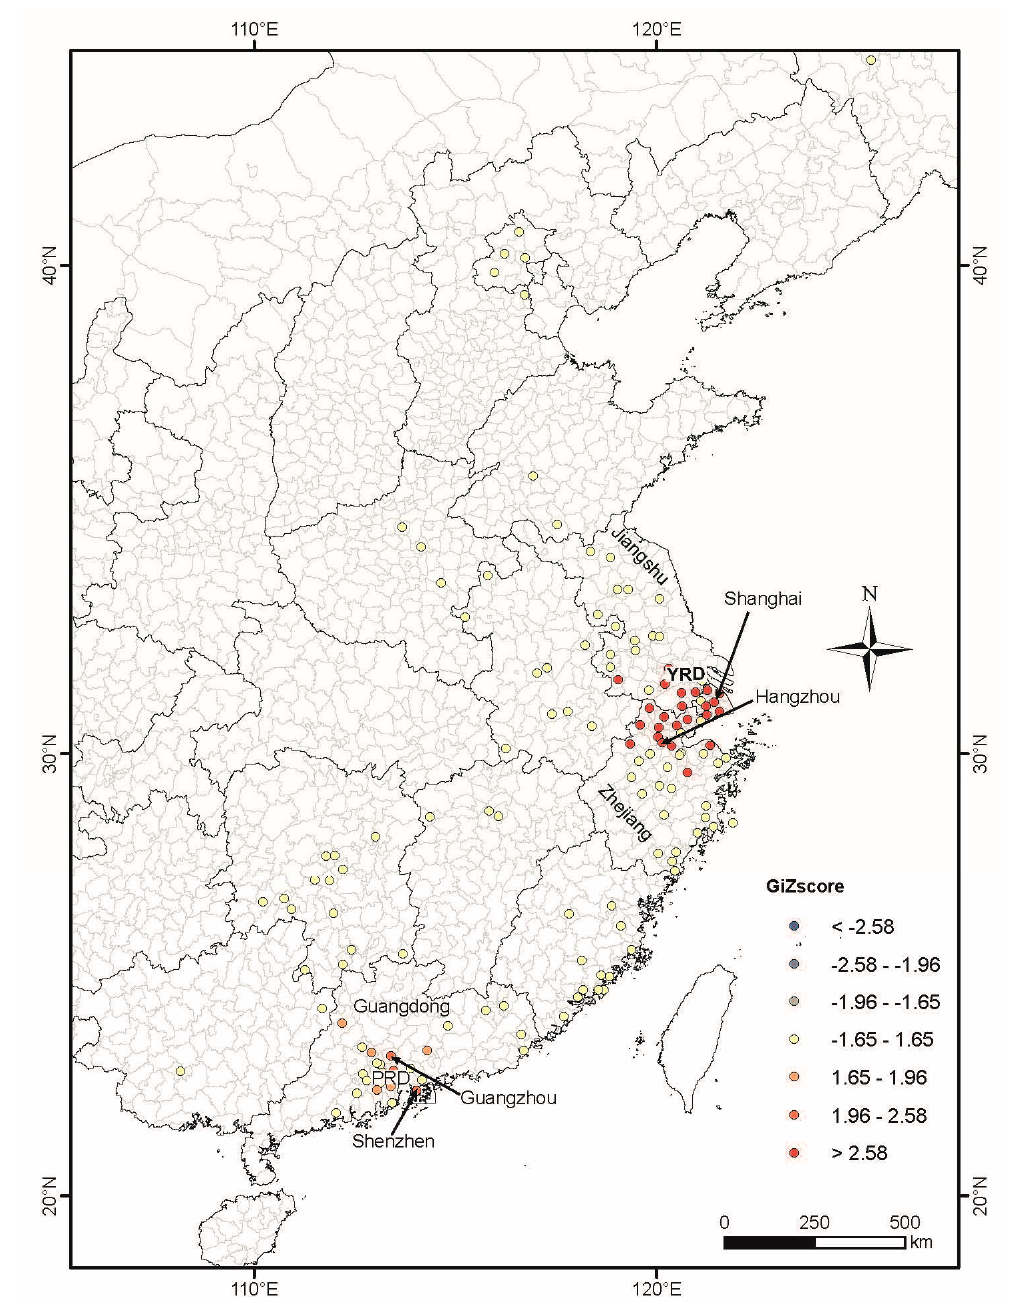
Figure 4. Spatial-temporal clustering of H7N9 cases analyzed using the Hot Spot analysis tool of software ArcMap™ 10.1. See caption in Figure 3 for statistical interpretation of the GiZscore. GiZscore is a measure of the statistical significance of spatial clustering and dispersing. A GiZscore < − 2.58 indicates dispersion at p = 0.01, − 2.58 to − 1.96 dispersion at p = 0.05, − 1.96 to − 1.66 dispersion at p = 0.1, − 1.66 to 1.66 random distribution, 1.66 to 1.96 clustering at p = 0.1, 1.96 to 2.58 clustering at p = 0.05, and >2.58 clustering at p =